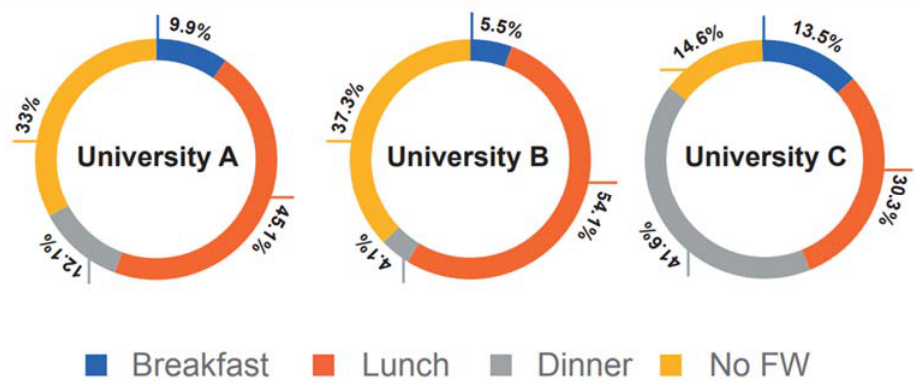
Figure 2. Food waste frequency per food time and respondents’ university.